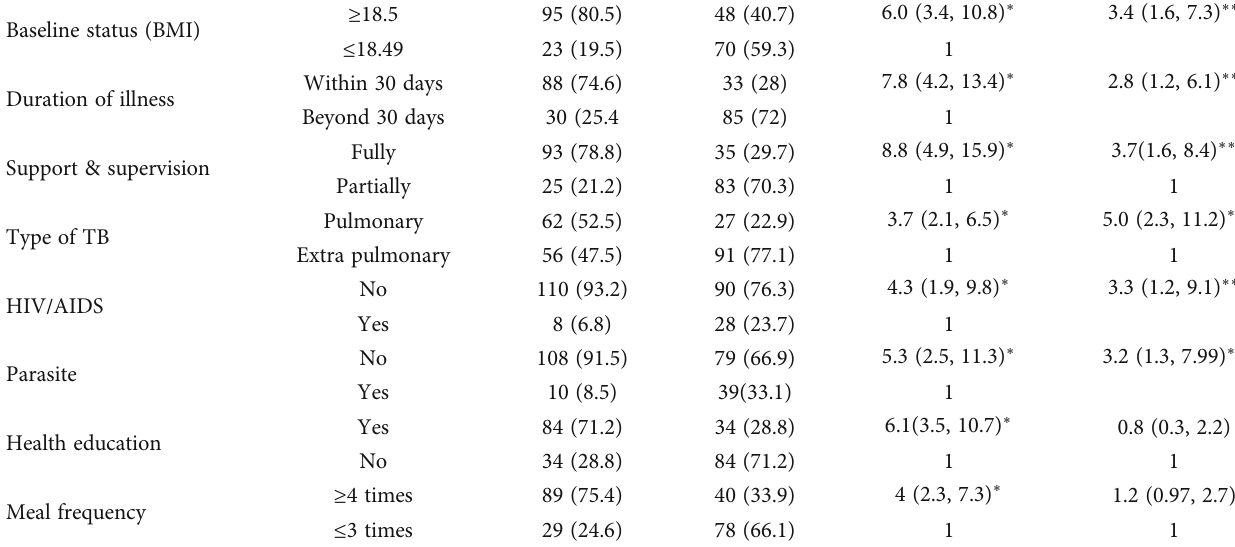
Table 6: Multivariable analysis result of determinants of weight gain among adult TB patients during the intensive phase in Debre Markos town public health facilities, Northwest Ethiopia,